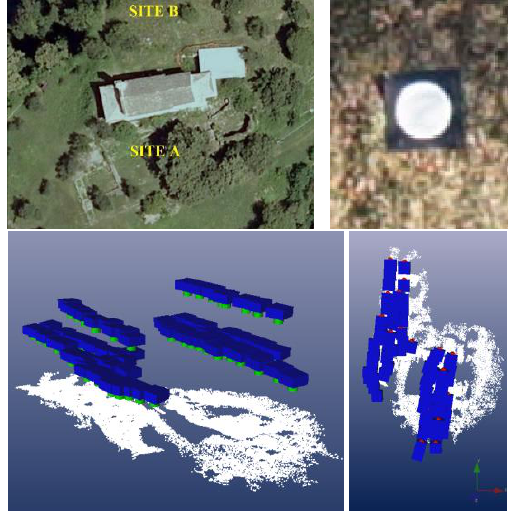
Fig. 7. Sites, a GCP and 3D visualization of orientation results (camera poses).